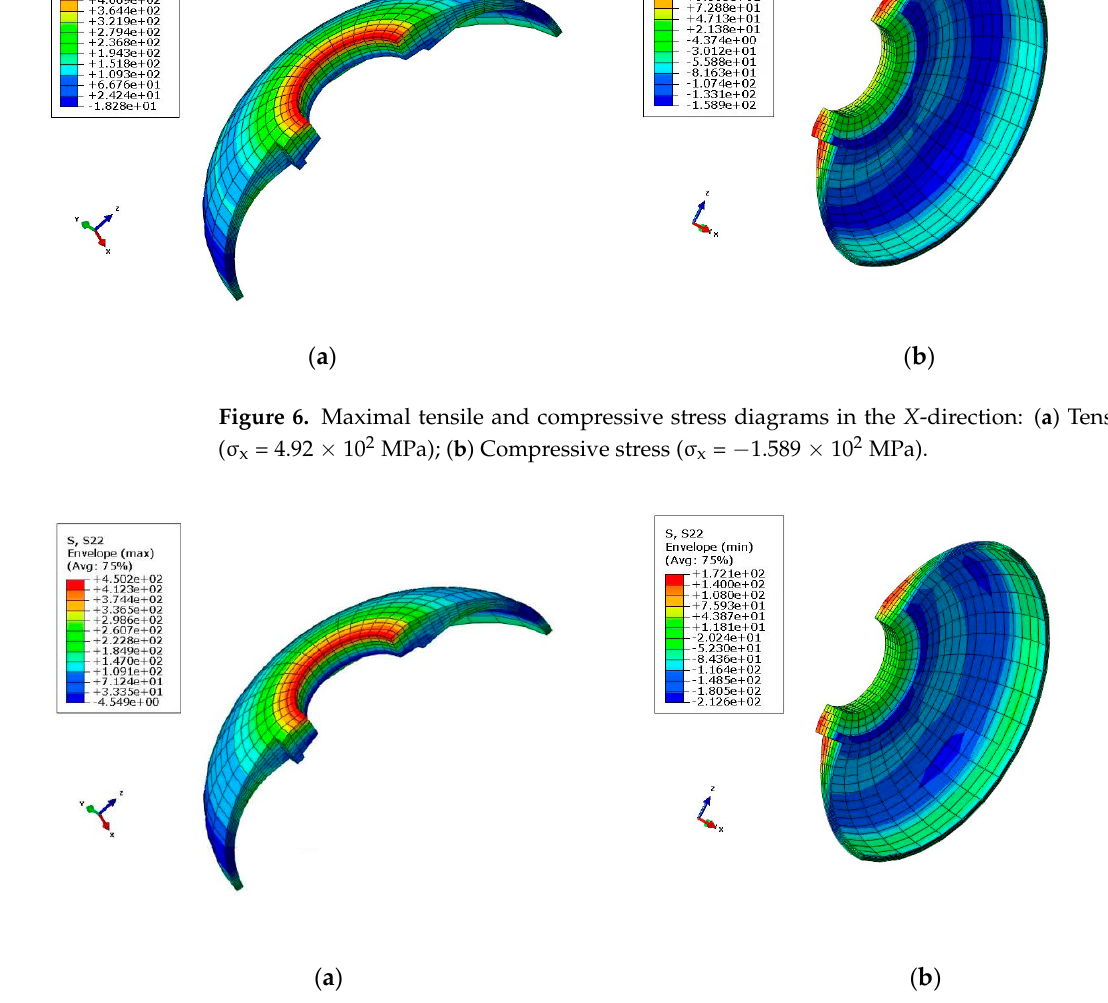
Figure 7. Maximal tensile and compression stress diagram in the Y -direction: ( a ) Tensile stress ( σ y